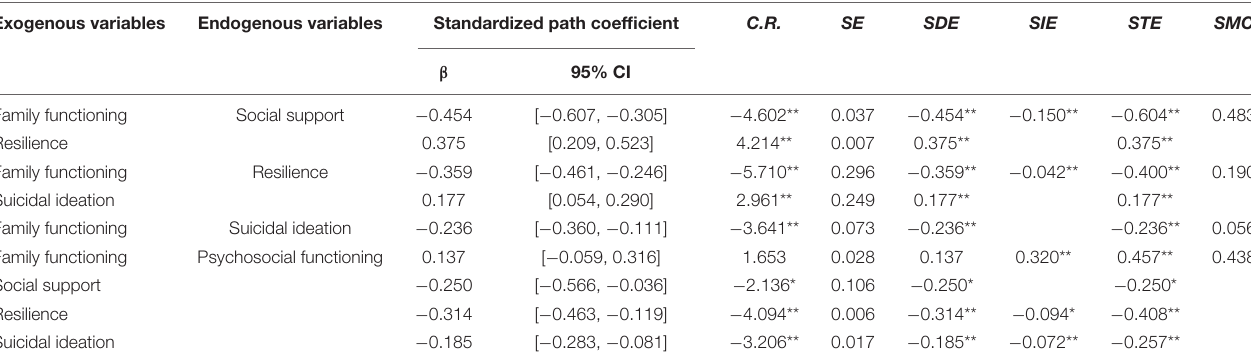
TABLE 5 | Standardized direct, indirect and total effects of family functioning on psychosocial